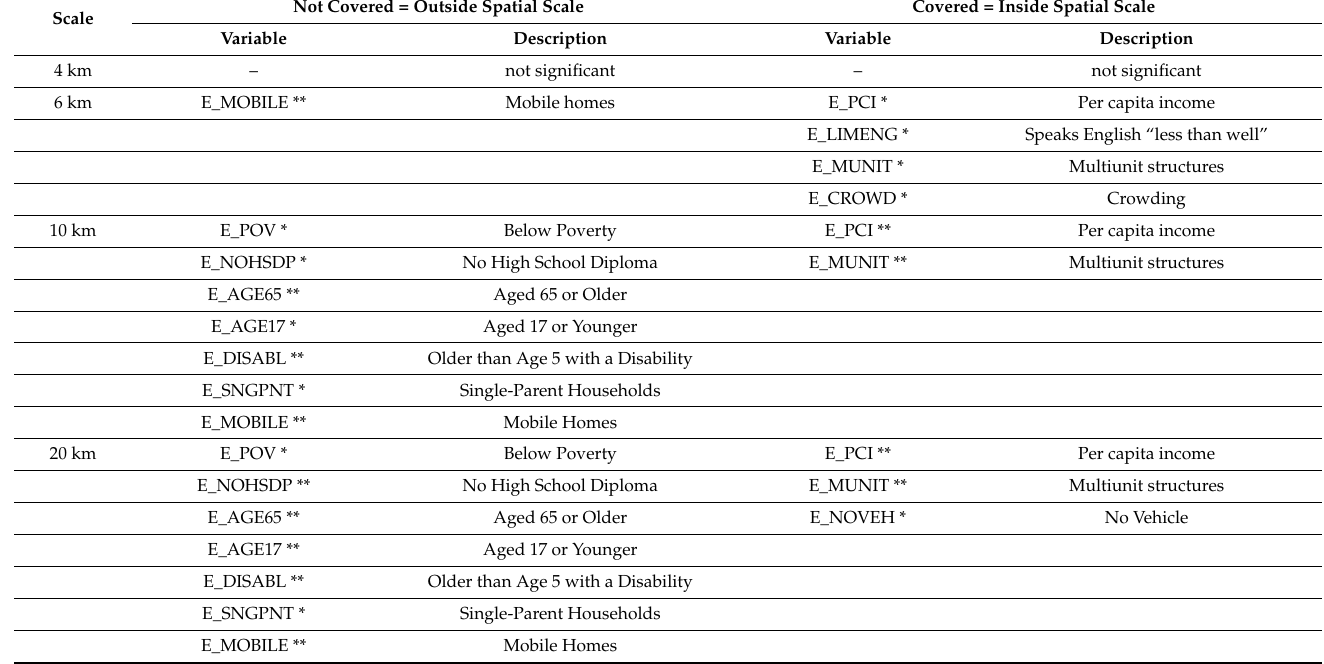
Table 1. Independent samples t -test on SVI variables by spatial